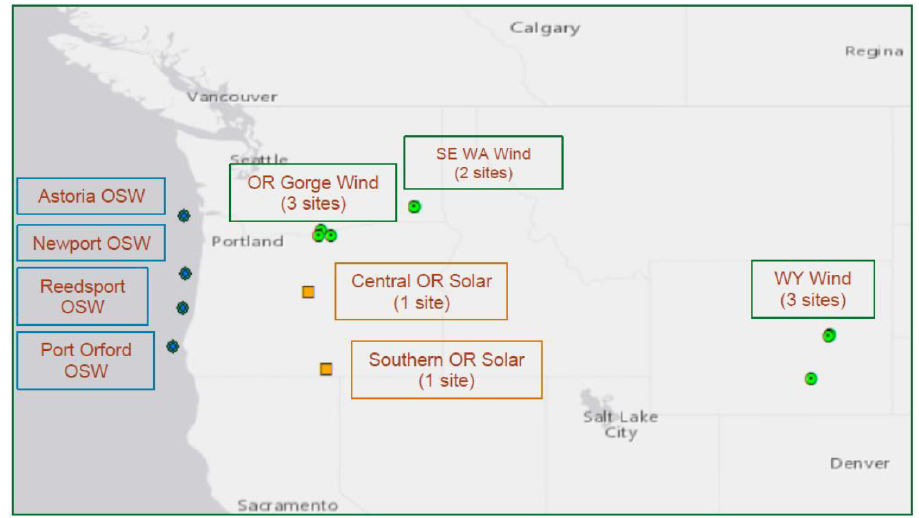
Figure 2. Renewable energy resource locations for resource complementarity study. Solar irradiance is quantified at hourly intervals in terms of direct normal irradiance (DNI) and global horizontal irradiance (GHI) in the National Solar Radiation Database (NSRDB) [18]. As with wind, because it is the nature of the resource that drives correlations in the time dimension, the conversion to units of power was not pursued in this study. However, depending on the orientation of panels and/or tracking systems, both the DNI and GHI could be important. To account for both factors, a simple magnitude of the irradiance resource was calculated through the square root of the sum of the squared DNI with the squared GHI at every